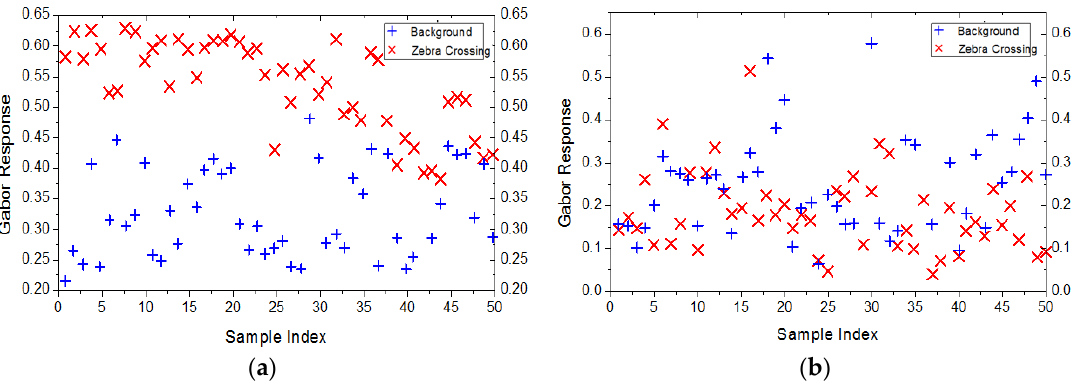
Figure 7. Distribution of the mean feature extracted by two groups of Gabor filters. The frequency of filters used in ( a ) is 0.1; while it is 0.2 in ( b ).